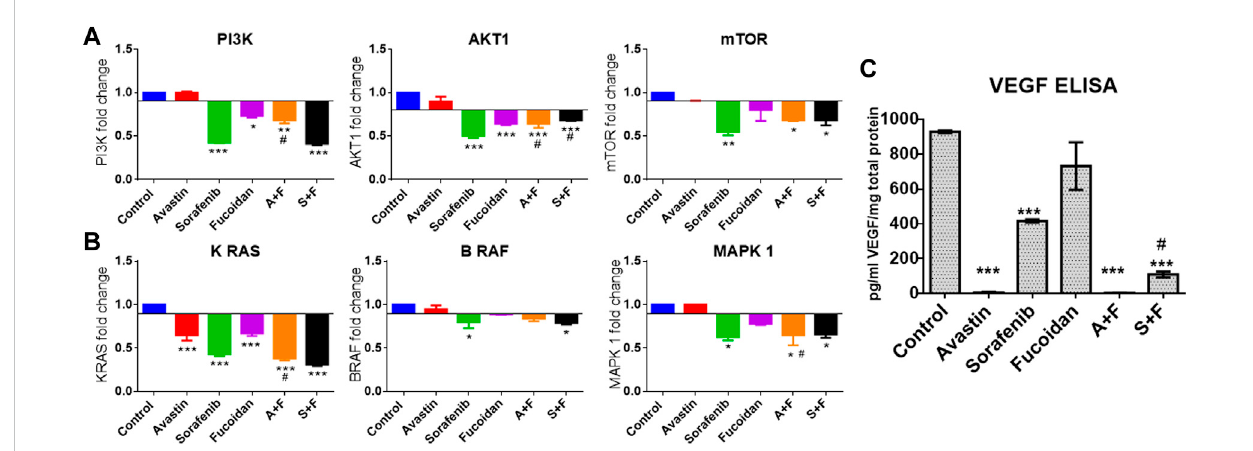
FIGURE 7 Effect of the drug combinations on VEGF and its downstream signaling molecules. (A, B) RT-qPCR results showing the fold change in mRNA levels (calculated using 2- ΔΔ CT method) of the key angiogenic genes: PI3K, AKT, mTOR, KRAS, BRAF and MAPK in HUH-7 cells. Sorafenib, A + F and S + F signi fi cantlyreducedtheexpressionoftheoncogenicPI3K/AKT/mTORandtheKRAS/BRAF/MAPKpathways.ThemostaffectedwerePI3KandKRASwith a decreased mRNA levels of 1.5 and 2.4 folds with A + F or 2.6 and 3.2 folds with S + F, respectively. (C) VEGF ELISA results showing a signi fi cant reduction inintracellular VEGF levels. Cells treated with Avastin and A + F showed thestrongest reduction followed by S + F, sorafenib and fucoidan. * p <